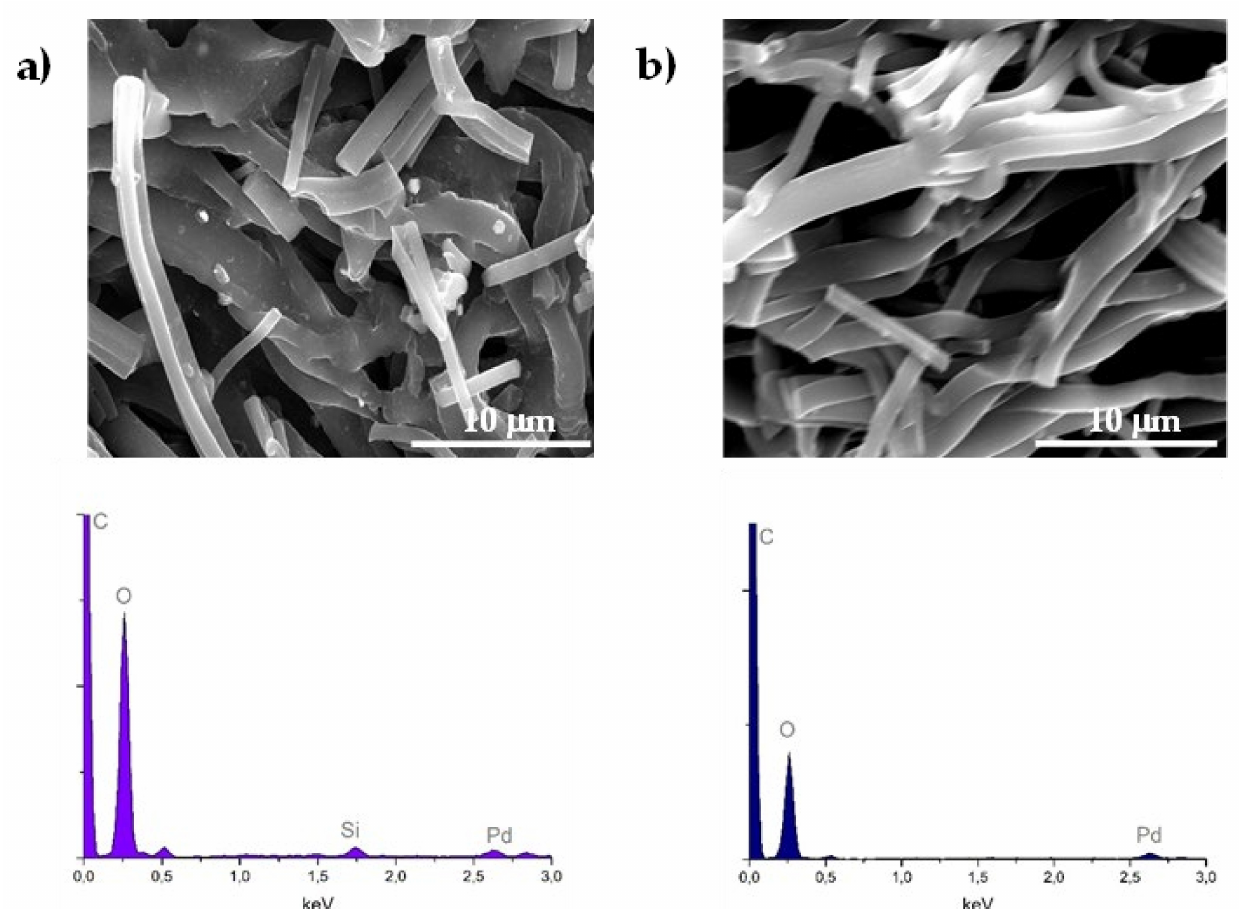
Figure 8. SEM/EDS results of 1% Pd/CF1 ( a ) before catalytic reaction and ( b ) after a third run of the reutilization